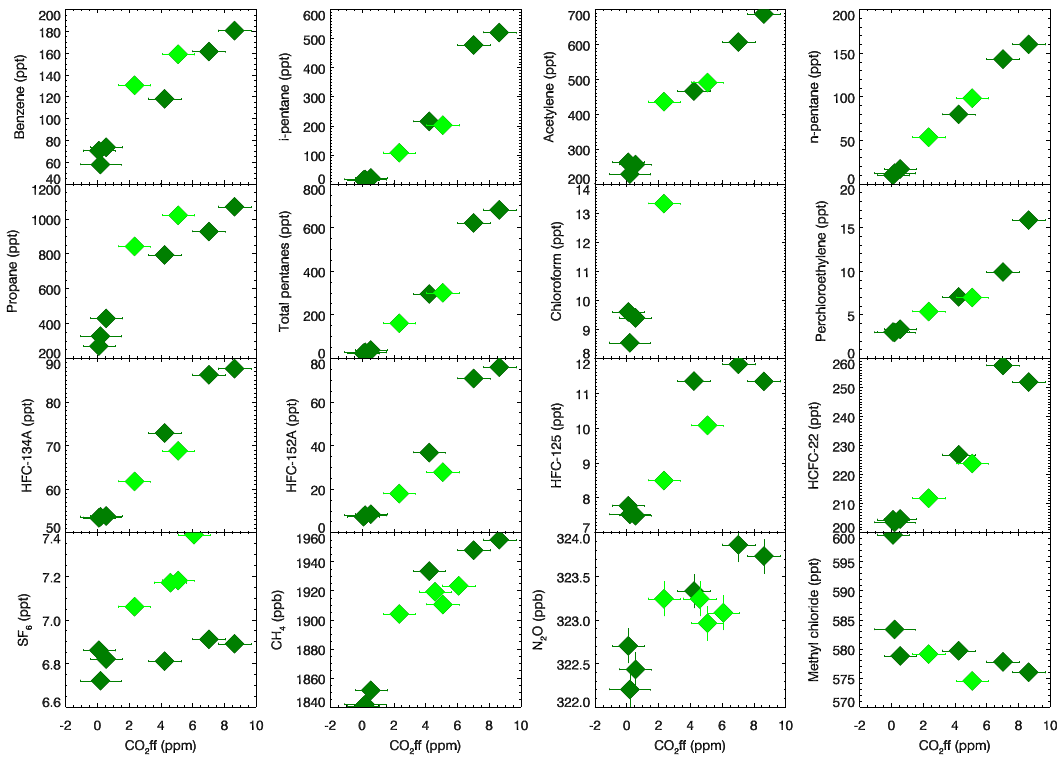
Fig. 5. Correlations between CO 2 ff and selected species measured in the same flasks. Dark and light green symbols are flasks from SAC227 and SAC306, respectively. Lines are the linear regression with errors in both coordinates for flasks from both flights combined. Errors on the y-axis are often smaller than the symbol